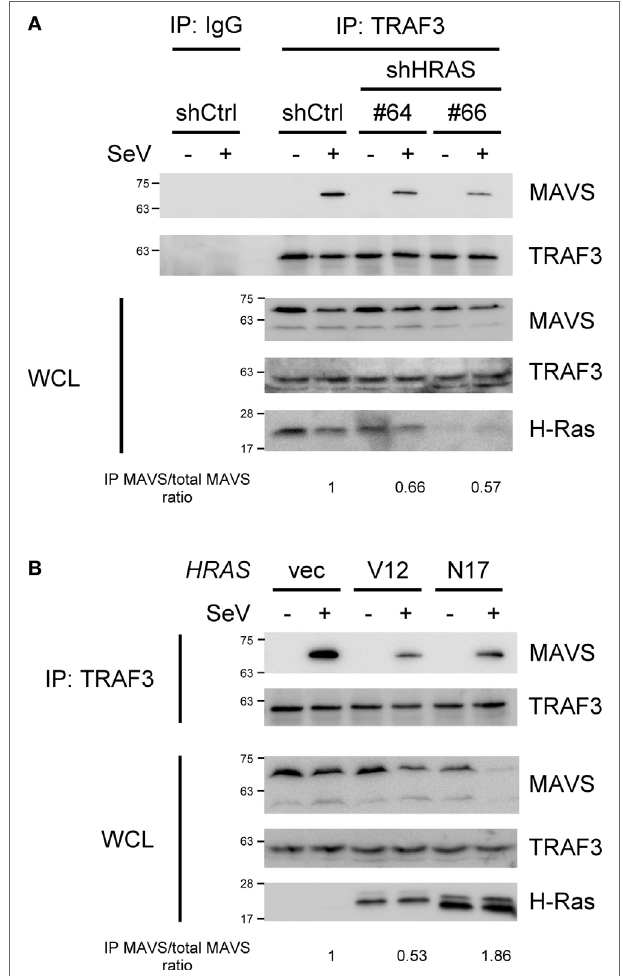
FigUre 5 | H-Ras and H-RasN17 enhances the formation of the MAVS–TNF receptor-associated factor 3 (TRAF3) signaling complex, whereas H-RasV12 reduces it. (a) HEK293T cells were depleted of H-Ras by shHRAS#64 or #66, or (B) cells were transfected with vector, the HRAS V12 DNA (15 ng/ml), or the HRAS N17 DNA (60 ng/ml) at the indicated doses shown in the parenthesis. In all groups, the total amounts of transfected DNA were adjusted to the same using the control vector DNA. After knockdown or DNA transfection, the cells were then mock infected or infected with Sendai virus (SeV) (20 HAU/ml) for 24 h. Cell lysates were immunoprecipitated with an anti-TRAF3 antibody or control IgG antibody, followed by Western blot analysis using anti-MAVS and anti-TRAF3 antibodies. WCL, whole cell lysate. The ratios of immunoprecipitated MAVS relative to total MAVS are shown at the